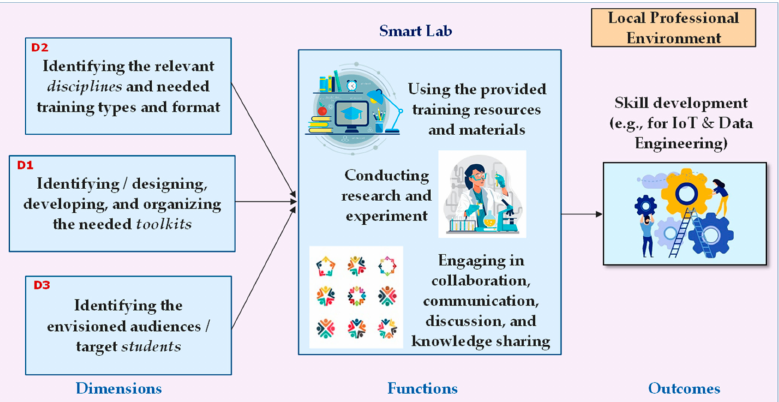
Figure 1. A matrix model, addressing the main dimensions and functions for developing the industrial and technical skills of